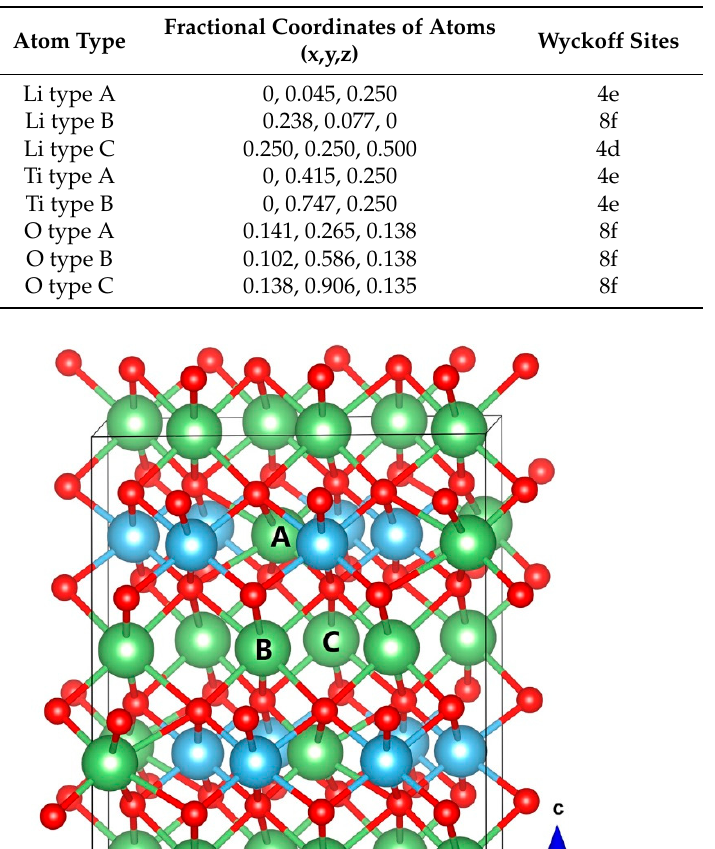
Table 1. Structure data of Li 2 TiO 3 crystal.